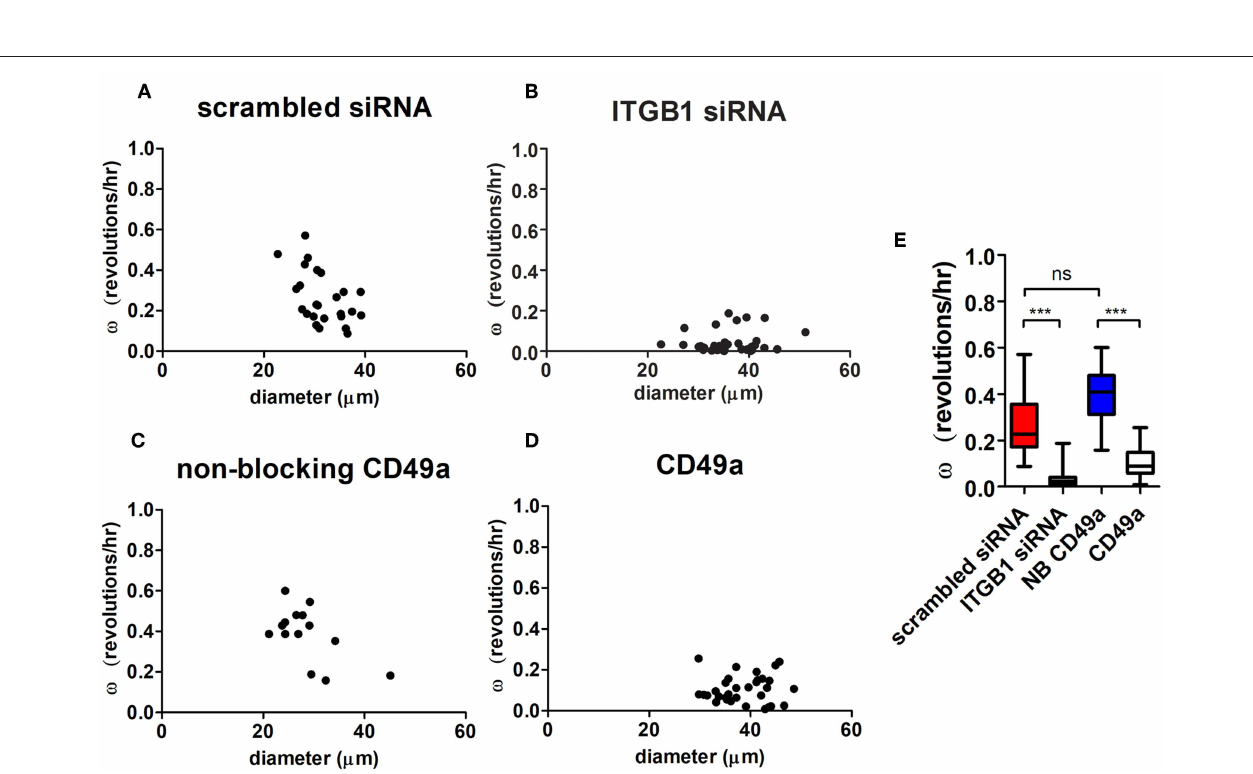
FIGURE 6 | Integrin inhibition diminishes microstructure motility in HA-based hydrogels. Angular velocities ( ω ) of hS/PC microstructures were plotted with respect to size (A–D) . The ω of hS/PC structures treated with siRNA targeting β 1 integrin demonstrated an 84% mean reduction in ω compared to its control ( p < 0.0001). Organized hS/PC structures treated with integrin blocking antibody CD49a resulted in a 73% reduction in ω when compared to its non-blocking CD49a control ( p < 0.0001) (E) . The ω of hS/PC structures treated with scrambled siRNA and non-blocking CD49a control groups were not significantly different from each other, p =